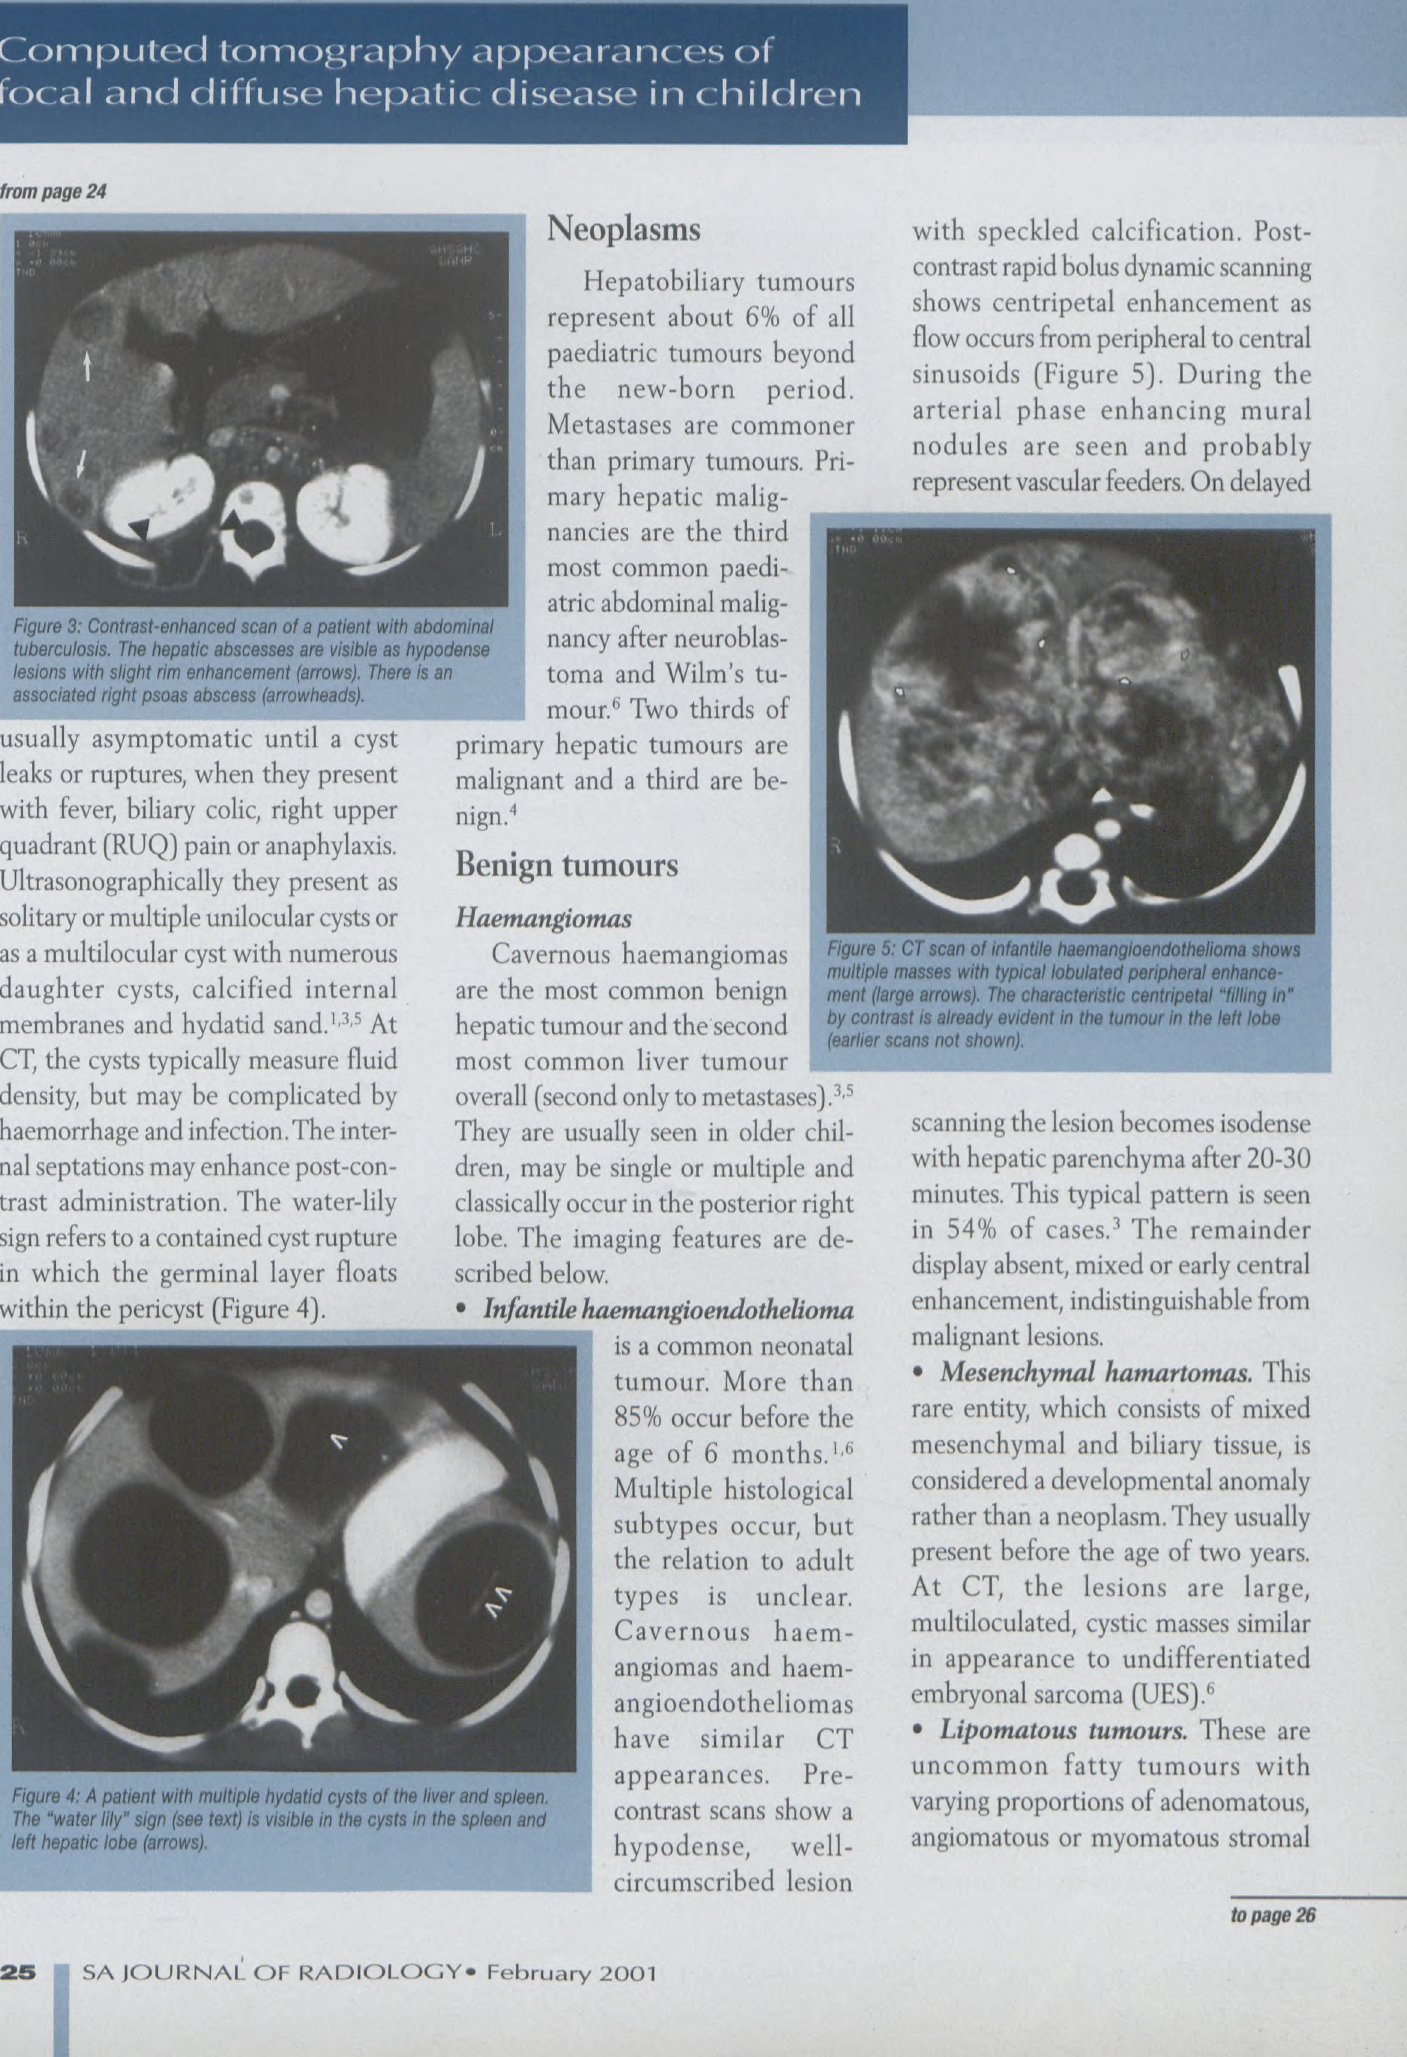
Figure 3: Contrast-enhanced scan of a patient with abdominal tuberculosis. The hepatic abscesses are visible as hypodense lesions with slight rim enhancement (arrows). There Is an associated right psoas abscess (arrowheads).